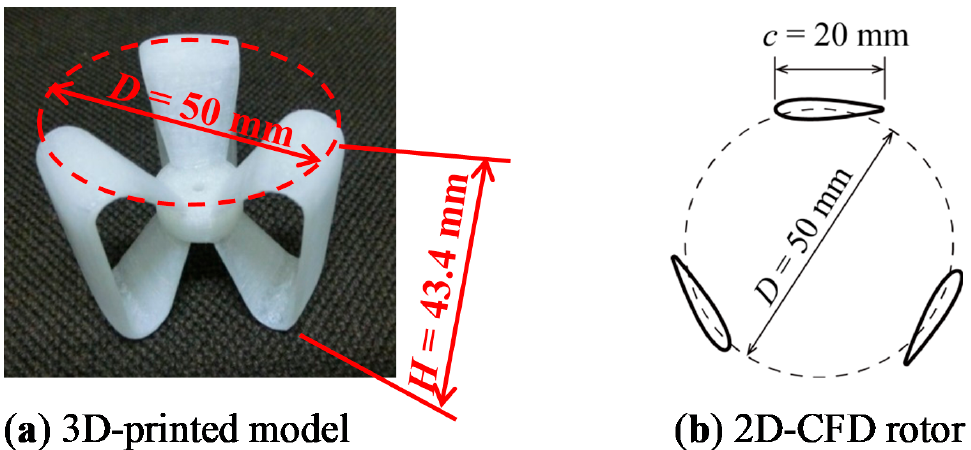
Figure 1. Target rotors of this study: ( a ) 3D printed model (3D-EXP rotor); ( b ) 2D-CFD rotor used for CFD analysis.